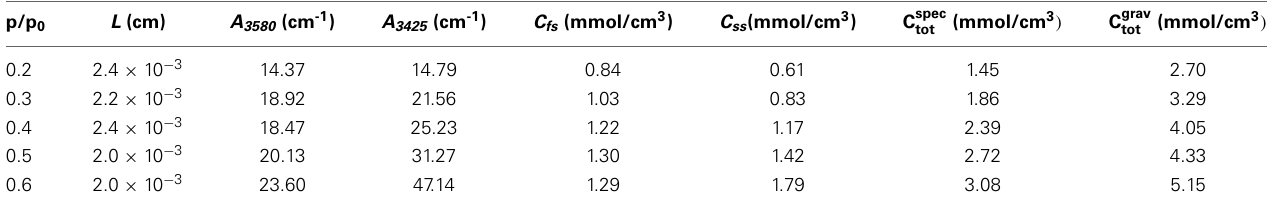
Table 1 | Sample thickness, absorbance of the resolved components, concentration of methanol species and total methanol concentration for the sorption tests performed at different relative pressures of methanol